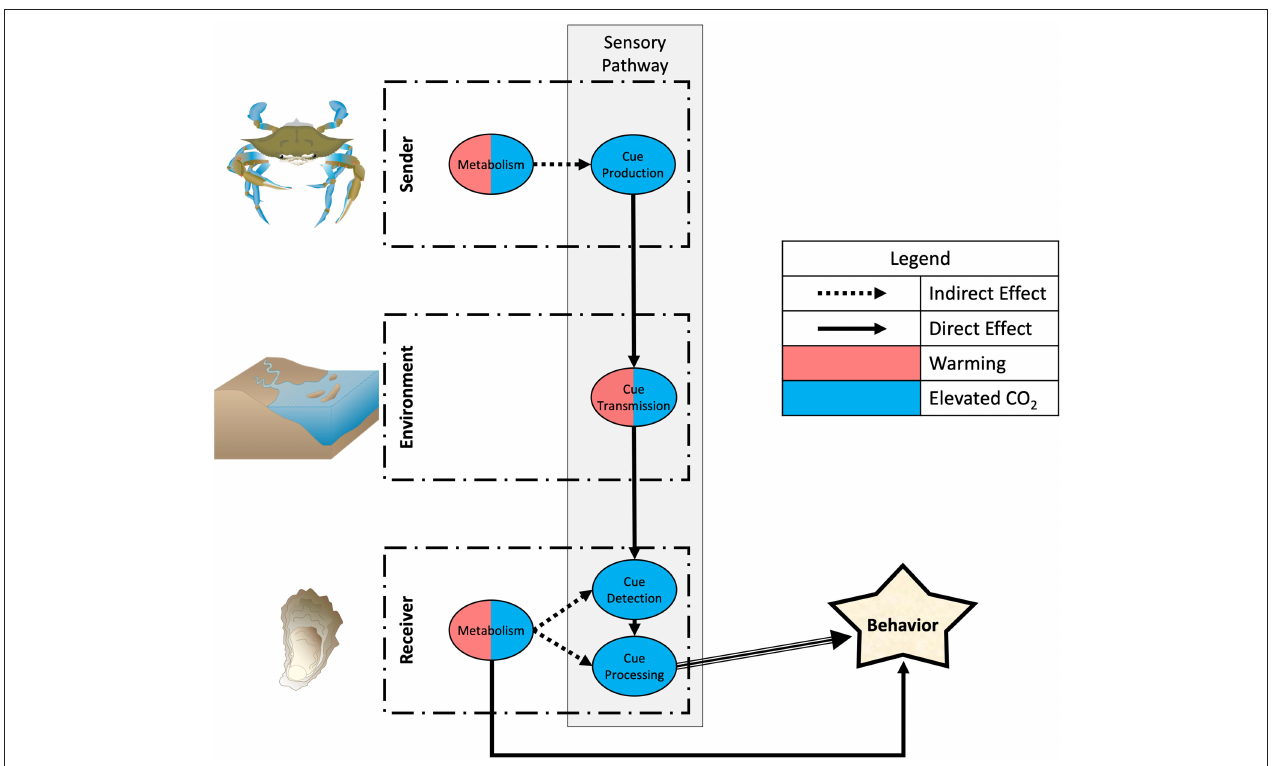
FIGURE 1 | Effects of global warming and elevated CO 2 on the sensory transduction pathway governing predator-prey interactions. The sender controls cue production and emission into the environment, which modulates cue transmission to the receiver. The receiver controls detection and processing of cue to determine behavioral response. Elevated CO 2 can directly affect sensory behavior via changes in cue production by the sender, transmission through the environment, and detection and processing by the receiver. Warming can affect cue production indirectly via physiological changes in activity and metabolic rates and can directly affect cue transmission. Note in this depiction that the sender is predator and the receiver is prey, but cues also pass from prey to predator so the roles also can be reversed. Symbols for diagrams courtesy of the Integration and Application Network, University of Maryland Center for Environmental Science